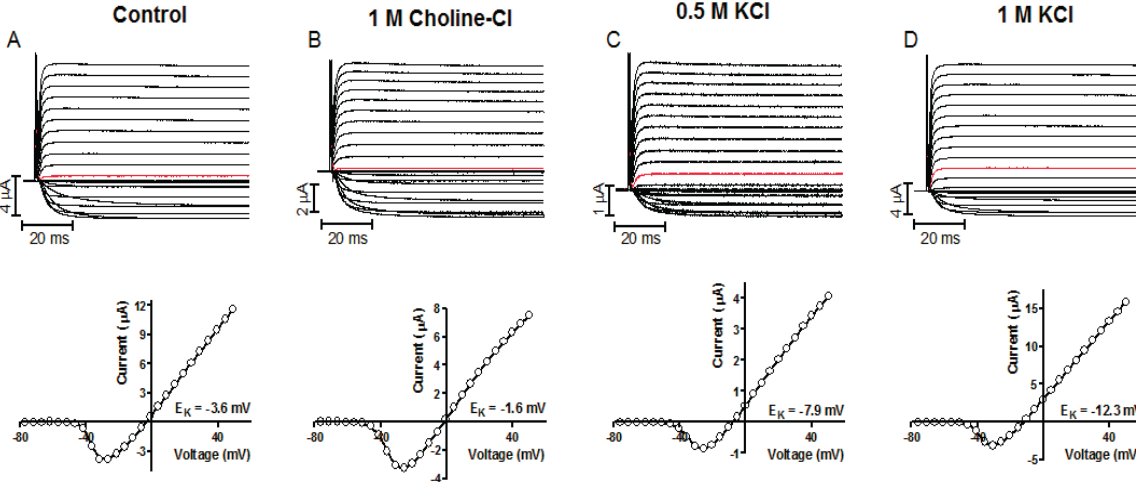
Figure 11. Representative K + current recordings and the corresponding I(V) curves measured electrophysiological in Kv channel expressing Xenopus oocytes. ( A ) Shows data for control oocytes and ( B – D ) for oocytes injected with indicated test solution. The holding potential was set to − 80 mV and test pulses ranging from − 80 to + 50 mV. The current generated by stepping to 0 mV is marked in red in each recording